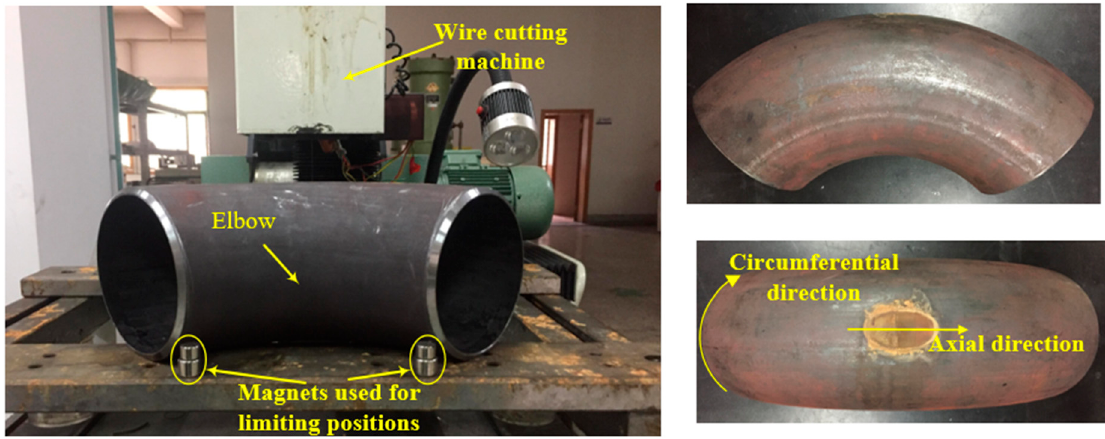
Figure 12. Process defect for elbow.